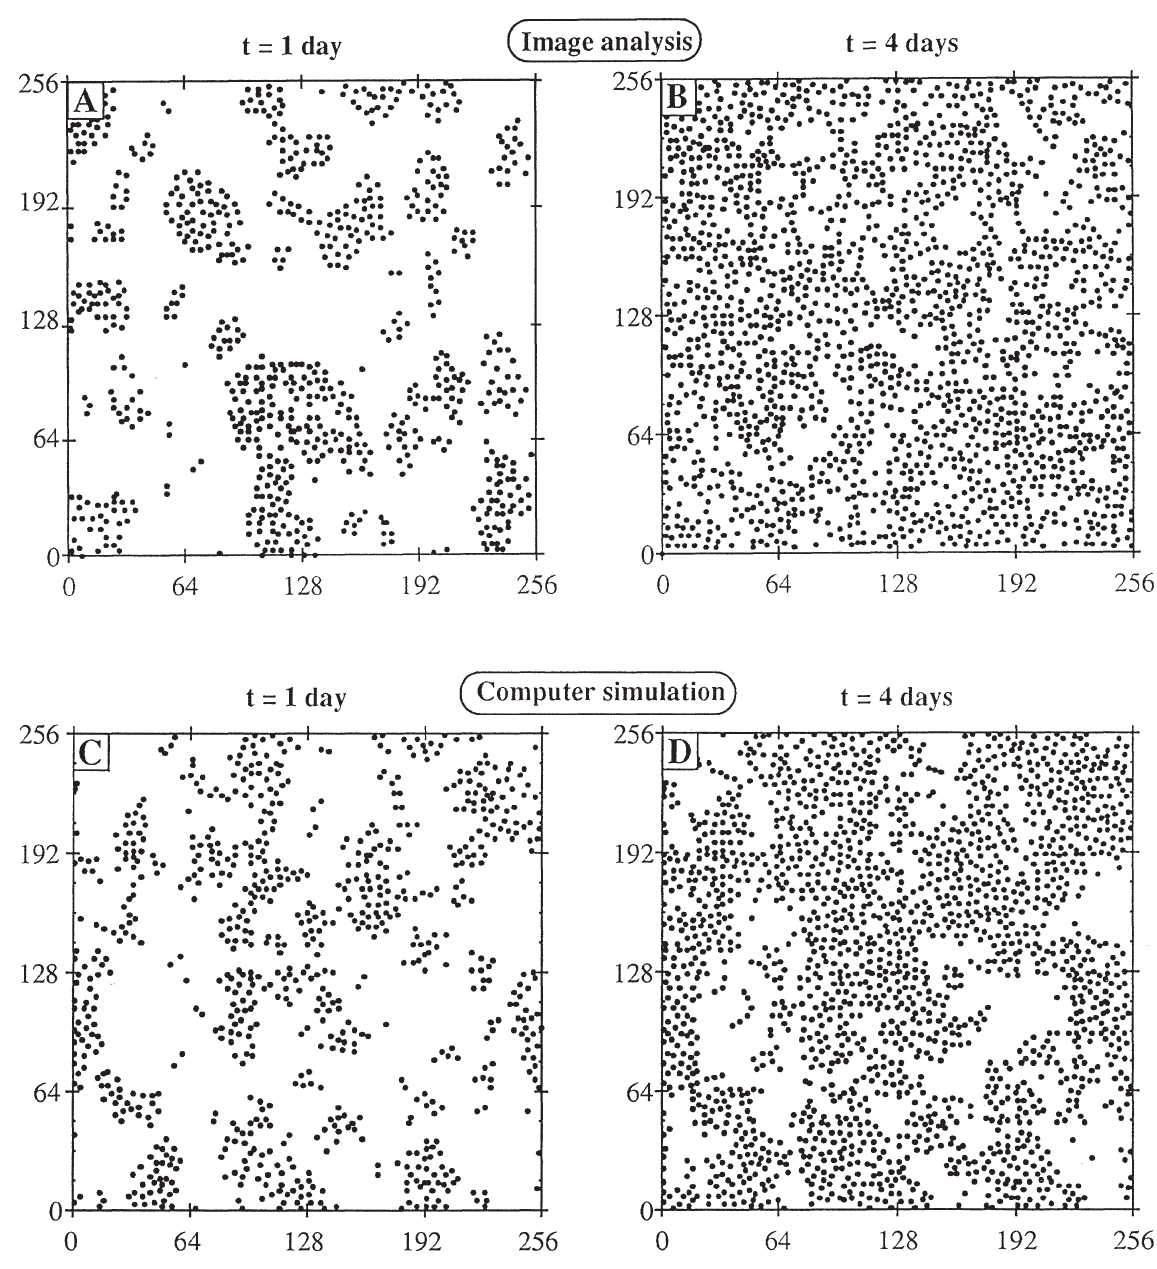
Fig. 7. Patterns obtained from (A) and (B) the image analysis 1 day and 4 days after the initial configuration, and (C) and (D) the computation process 1 day and 4 days after the initial configuration in Fig.